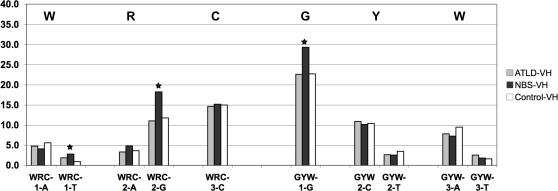
Frequency of mutations within the WRC/GYW motifs in VH3-23 sequences.Stars indicate that the frequency of mutations at a given position when it is significantly different in patients as compared to controls.